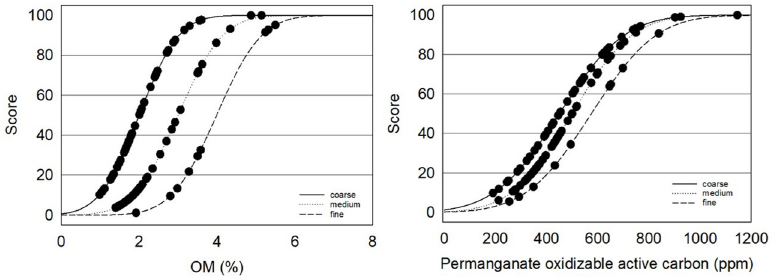
Fig 7. Soil organic matter (OM %) and permanganate oxidizable carbon (POXC ppm) in 101 Central Washington orchards fields.